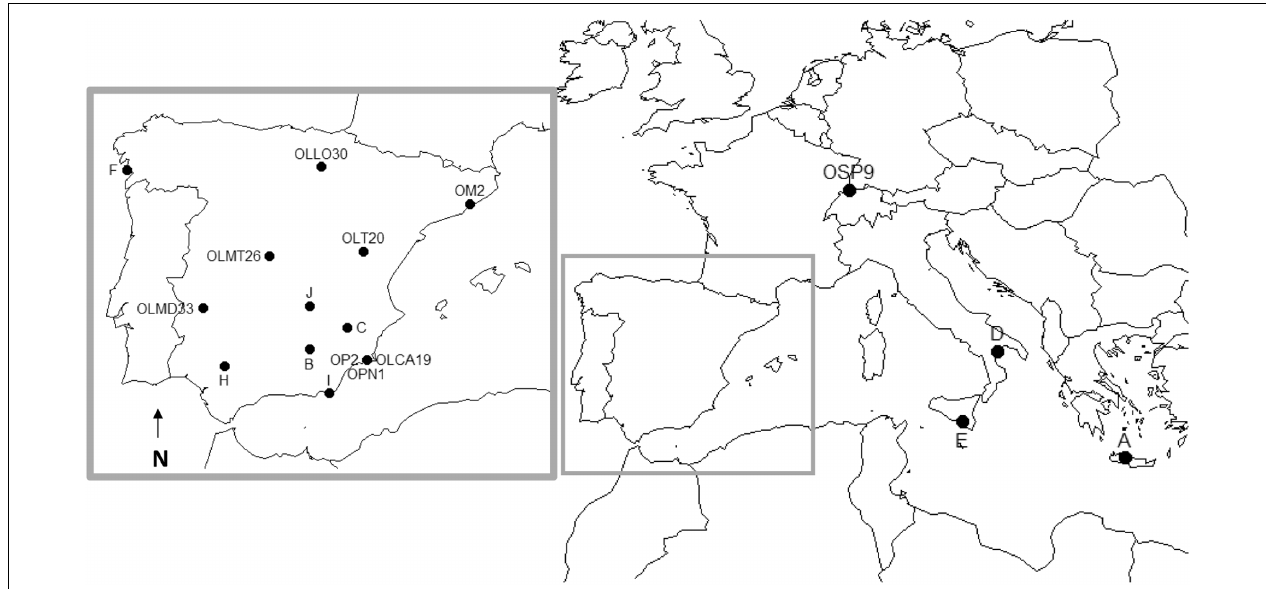
FIGURE 1 | Geographical locations where insect specimens were collected to establish lab-reared populations. O. pallidicornis collection sites are also shown. Description of populations is shown in Supplementary Table 1. O. laevigatus (A, B, C, D, E, F, H, I, J, OLLO30, OLMT26, OLT20, OLMD33, and OLCA19), O. majusculus (OM2), O. niger (OSP9), and O. pallidicornis (OPN1,